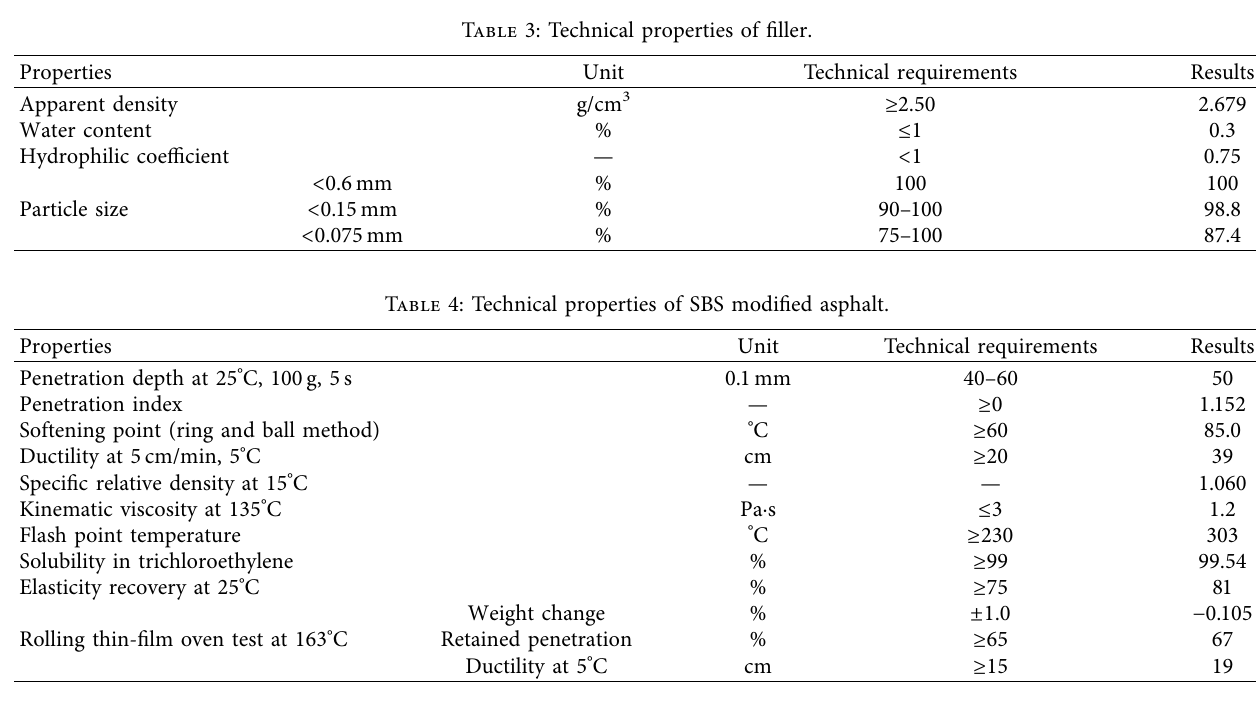
Table 5: Combined gradation.